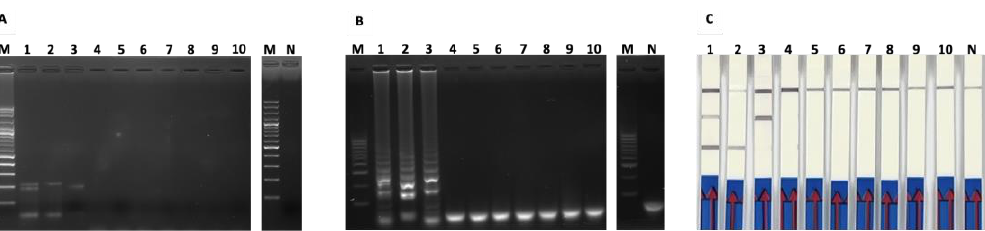
Figure 4. The analytical specificity tests for detection of PEDV spike gene and PCV2 ORF gene using ( A ) duplex PCR-based AGE, ( B ) duplex LAMP-based AGE and ( C ) duplex LAMP-LFD. Lane M represents 100 bp DNA ladder marker; Lane 1 represents duplex PEDV/PCV2; Lane 2 represents PCV2; Lane 3 represents PEDV; Lanes 4–10 represent Aujeszky’s disease virus (ADV), foot and mouth disease virus (FMDV), transmissible gastroenteritis virus (TGEV), porcine reproductive and respiratory syndrome virus European strain (PRRSV-EU), and porcine reproductive and respiratory syndrome virus US strain (PRRSV-US), respectively.